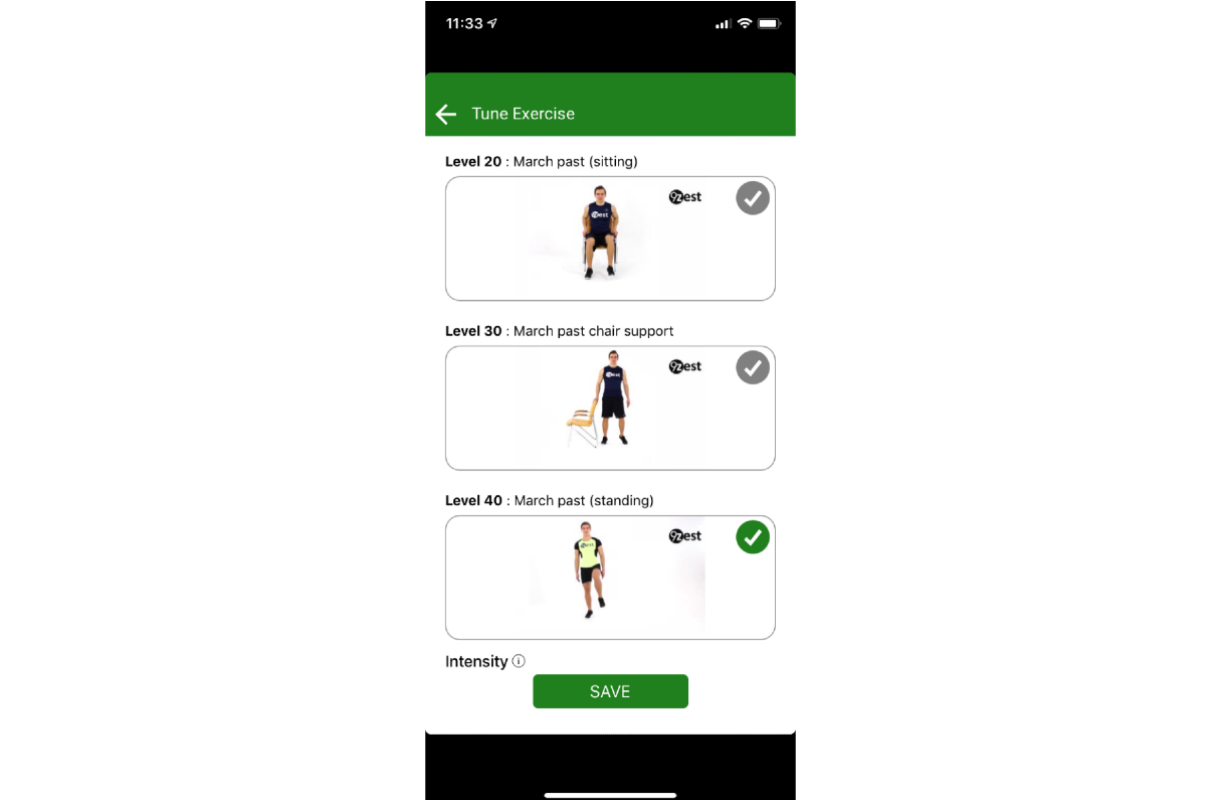
Figure 5. An example of graded exercises based on level of